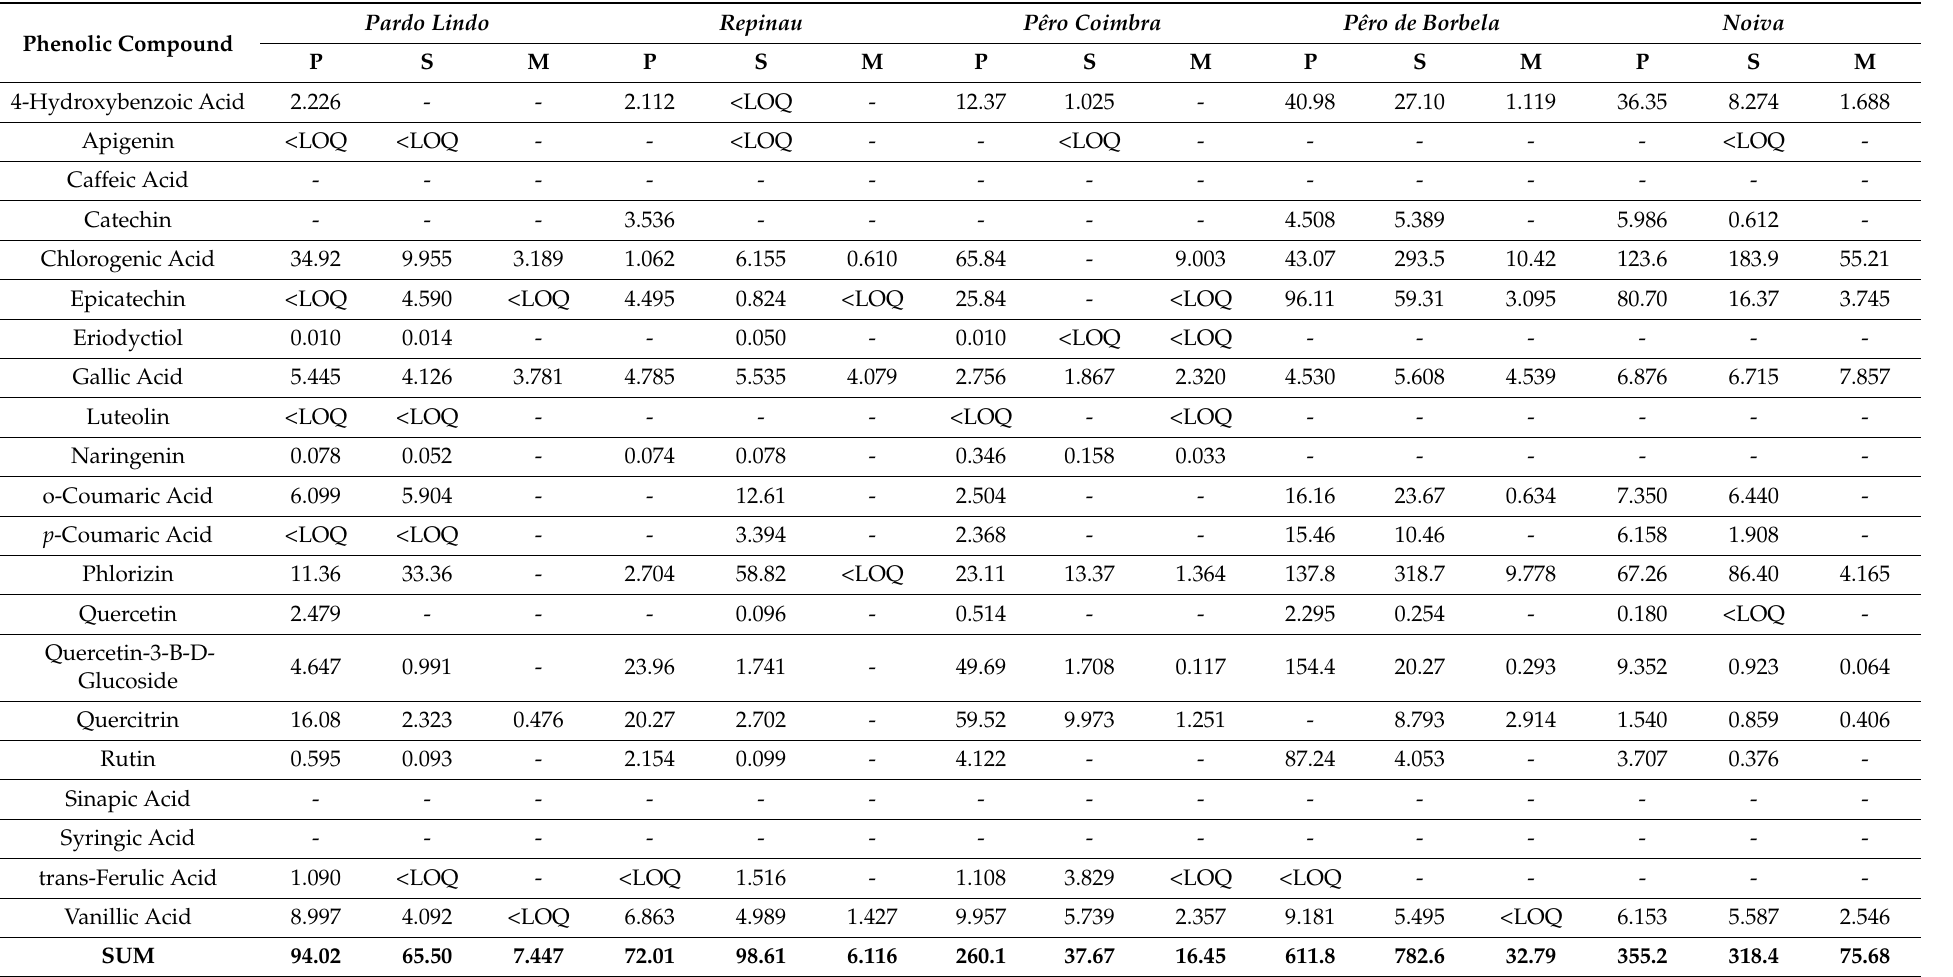
Table 9. Phenolic compounds ( µ g/g FW) in different parts of apple regional cultivars (P: Peel, S: Seed, M: Mesocarp